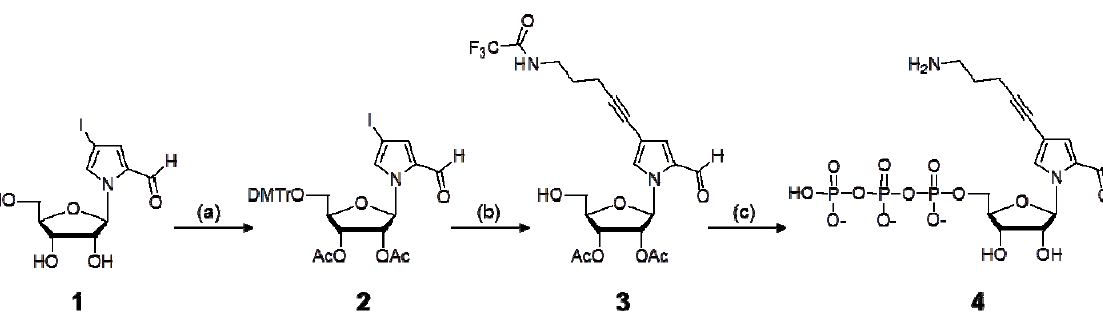
functional groups of 1-propyne, 3-(dichloroacetamido)-1-propyne, 5-trifluoroacetamide-1-pentyne, and N- (2-propynyl)-6-trifluoroacetamidohexanamide, respectively (Schemes 1 and 2). Scheme 1. Synthesis of the nucleoside 5 ′ -triphosphate of NH